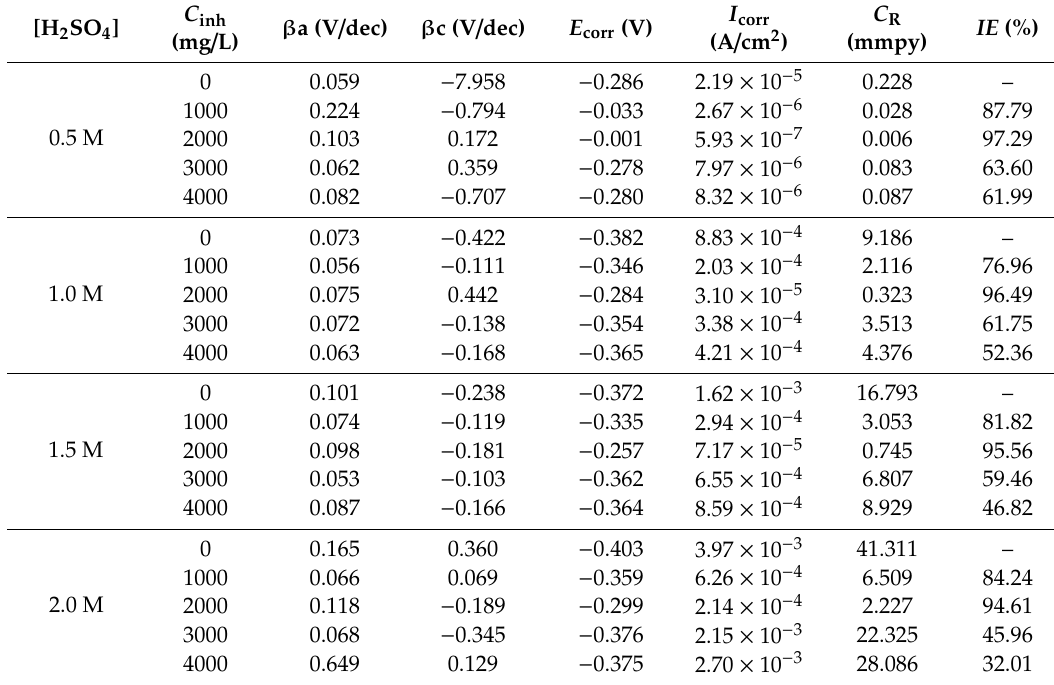
Table 2. Corrosion parameters for 304 SS in several H 2 SO 4 concentrations with and without